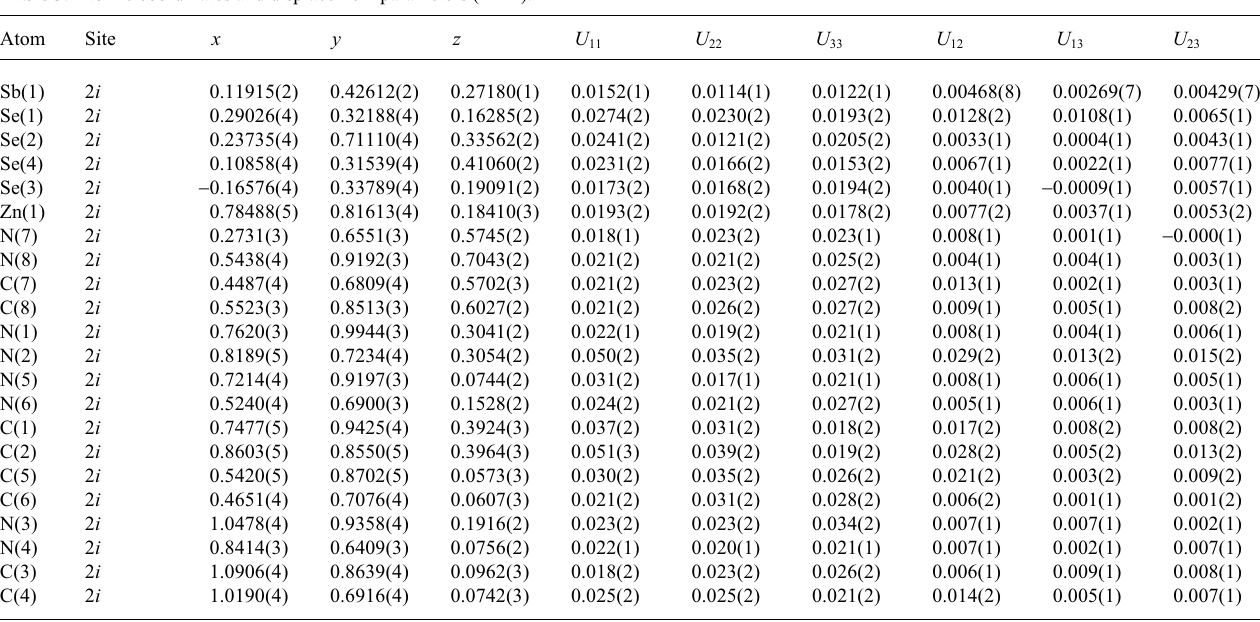
Table 3. Atomic coordinates and displacement parameters (in Å 2 )